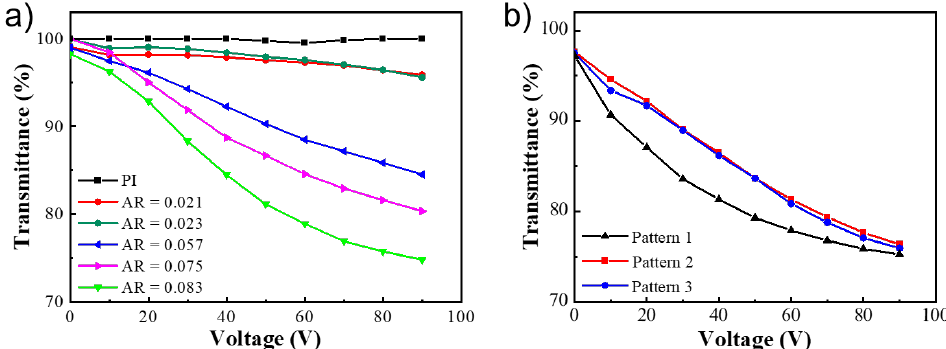
Figure 6. The transmittance as a function of AC voltage for polymer-free liquid crystal devices based on photo-embossed structure, with ( a ) increasing aspect ratios of pattern 1, and ( b ) three different patterns.